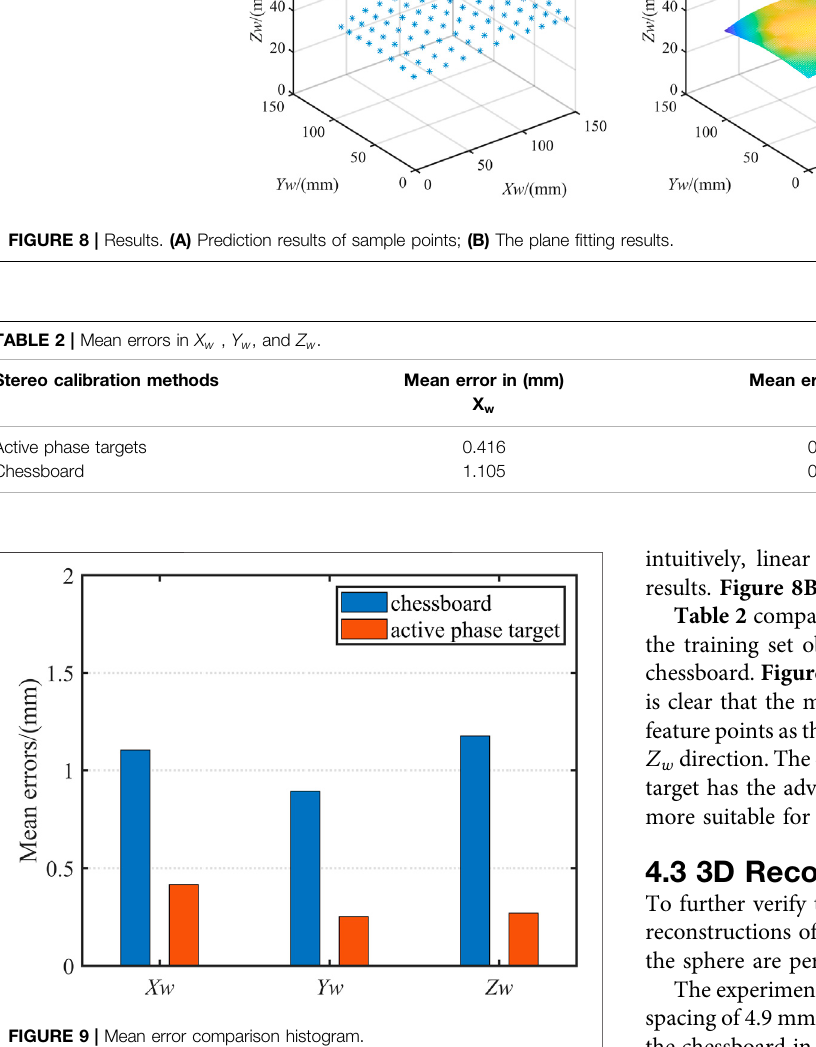
FIGURE 9 | Mean error comparison